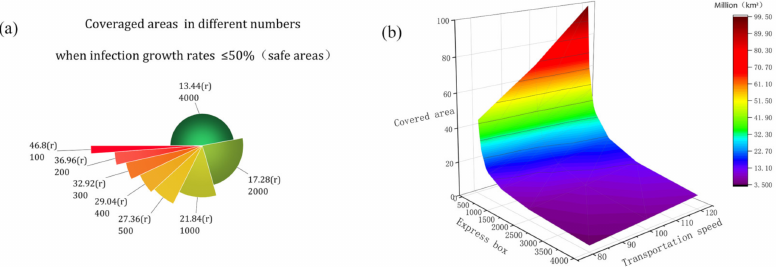
Figure 6. ( a ) is the radius of the optimal geographical area for the prevention of courier box viruses in different number of express boxes and ( b ) is the effect of courier vehicle travel speed and the number of boxes on the optimal area for